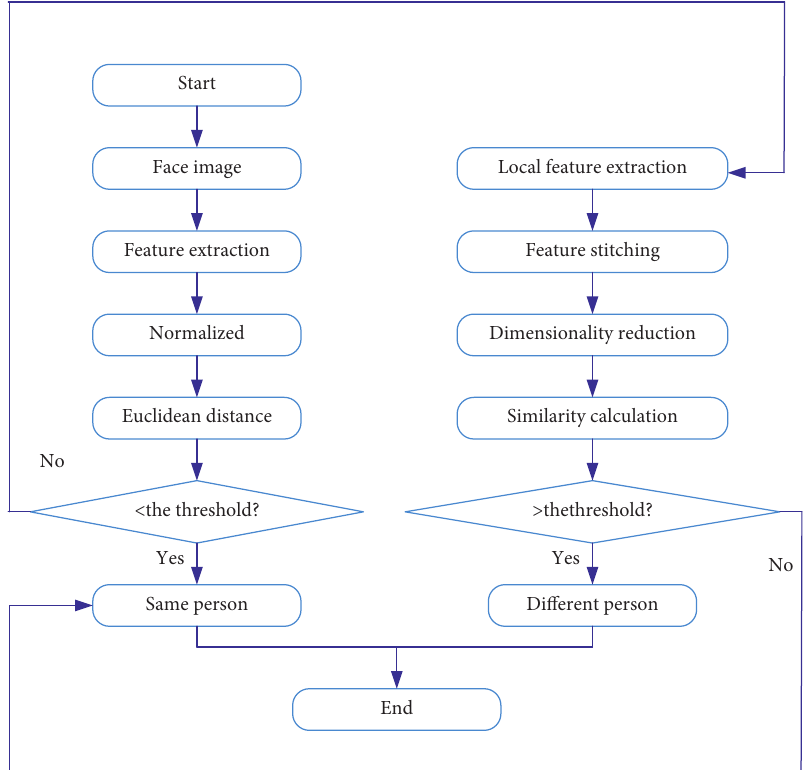
Figure 6: Matching process of face feature points.